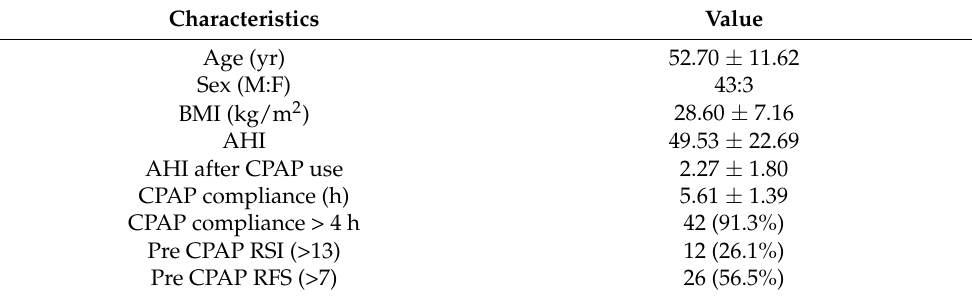
Table 3. Characteristics of obstructive sleep apnea patients ( n =